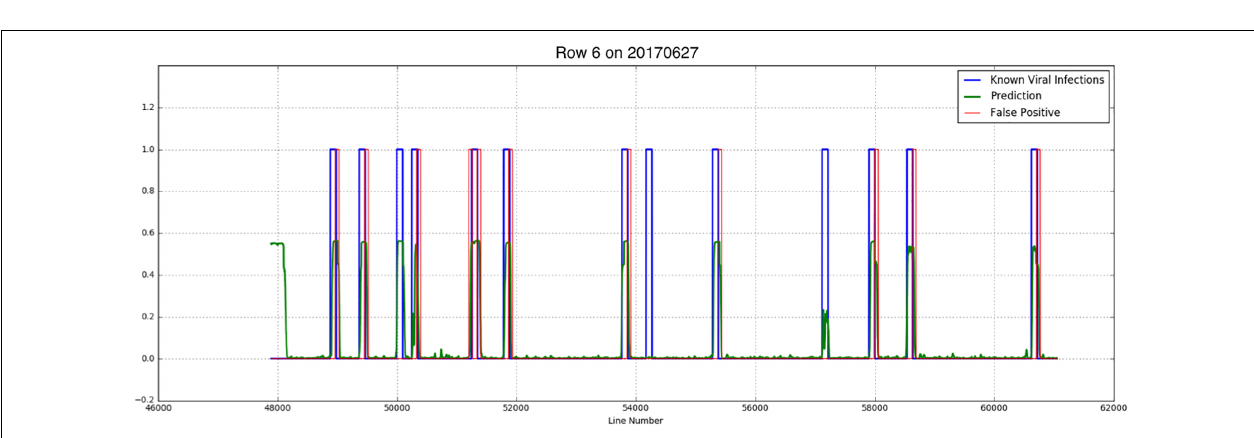
FIGURE 11 | False positives are closely connected to true